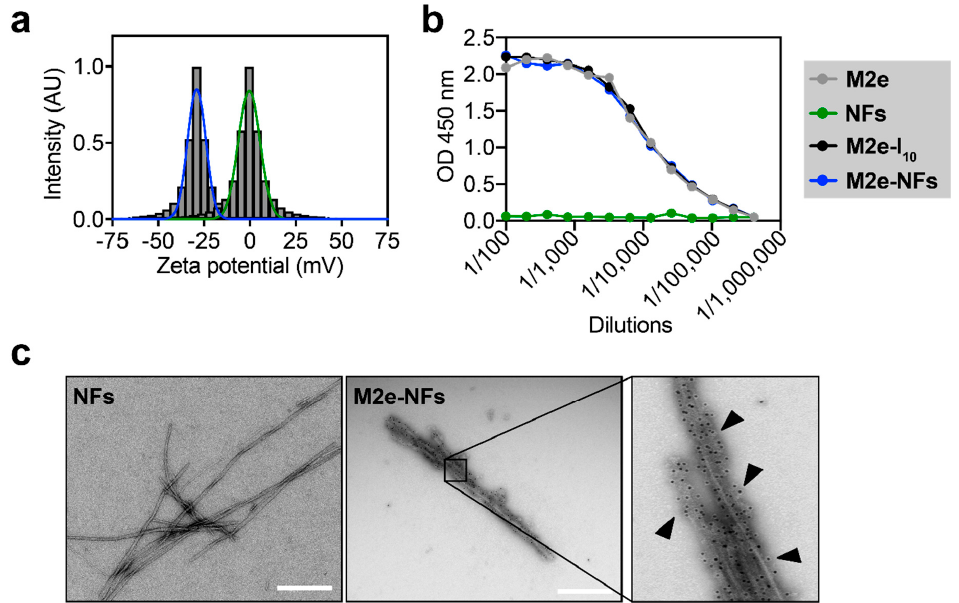
Figure 4. M2e-NFs display high density of the M2e epitope at the surface. (a) Measurement of zeta potential indicating the surface charge of M2e-NFs and of non-functionalized NFs. (b) ELISA analysis of M2e peptide, NFs, monomeric M2e-I 10 and M2e-NFs. (c) TEM images of NFs and M2e-NFs after immunogold staining with anti-M2 primary antibody and gold-conjugated secondary antibody.